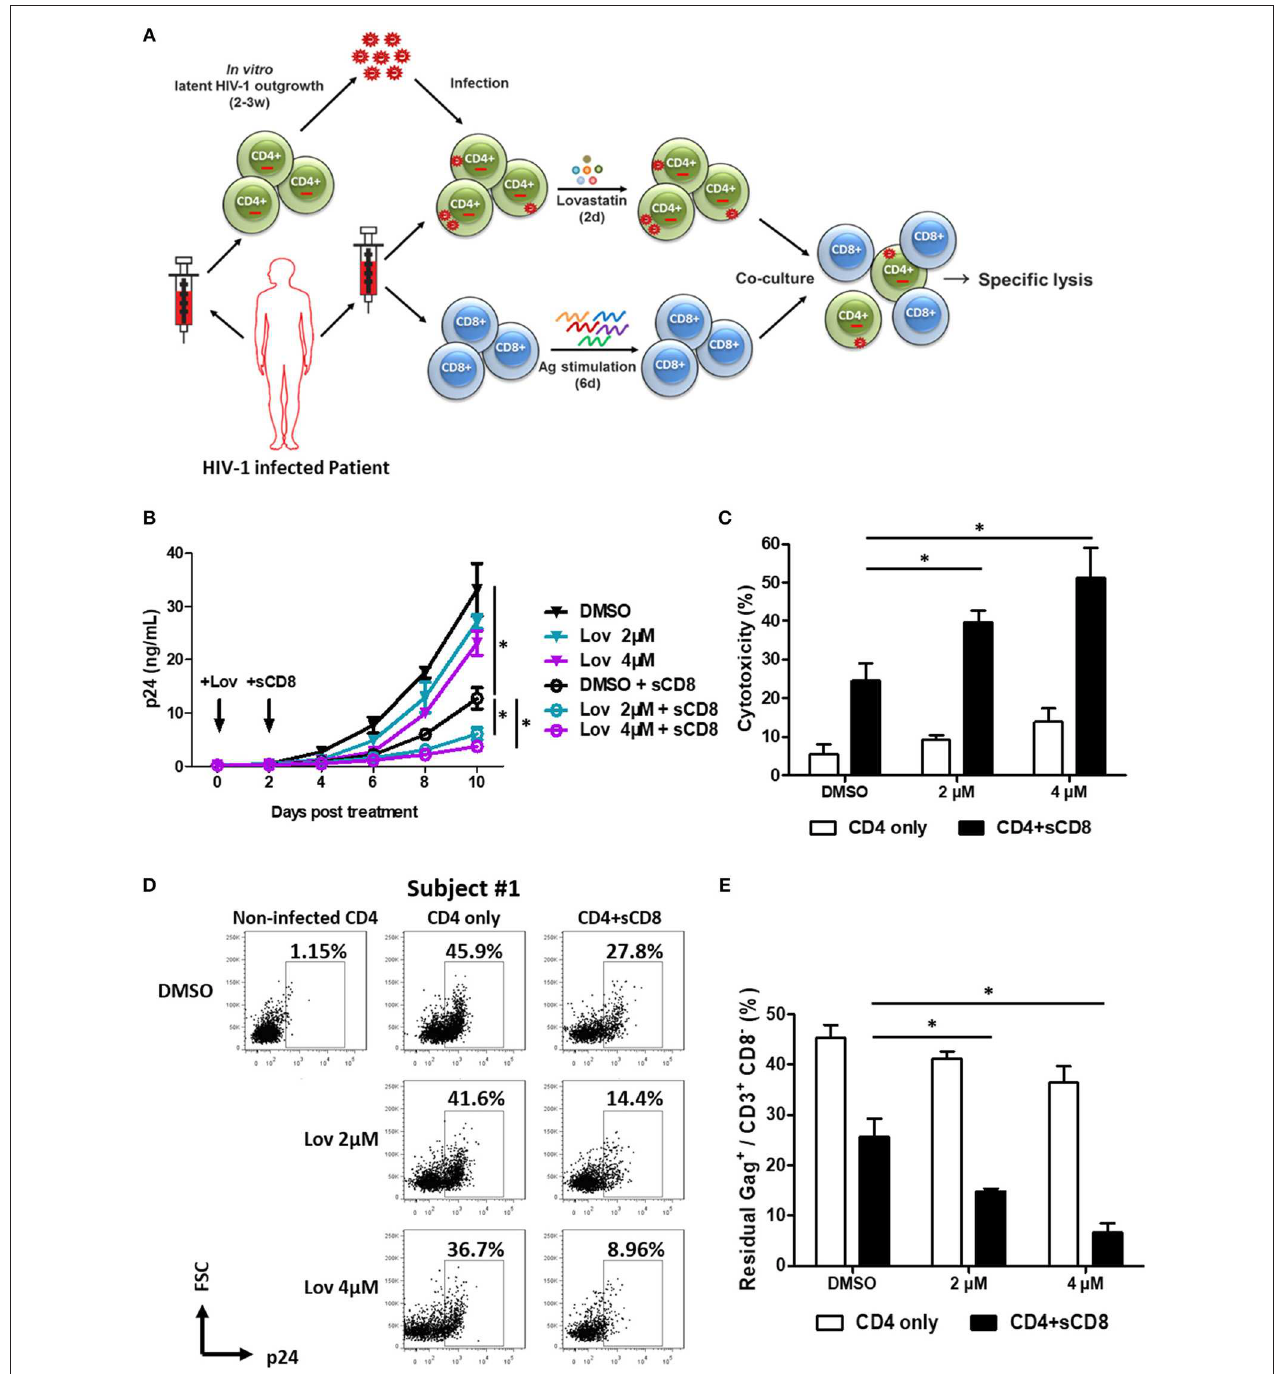
FIGURE 5 | Pre-treatment of lovastatin boosts autologous CTL response against the reactivated latent reservoir from HIV-1 infected individuals. Experimental design. The activated CD4 + T cells from HIV-infected individuals receiving suppressive cART were infected with the viruses recovered from the resting CD4 + T cells of same patients, CD4 + T cells were incubated with lovastatin or vehicle for 48h, then the cells were washed and mixed with autologous Gag peptides-stimulated CD8 + T cells at a 1:1 ratio (A) . Every 2 days the cultures were tested for HIV-1 p24 antigen by ELISA (B) . Eight days after co-culture, specific killing of infected CD4 + T cells by autologous CTLs was determined by LDH assay (C) . The residual Gag + T cells gated on CD3 + CD8 − subpopulation were analyzed by flow cytometry (D) . The ratios of residual Gag + to CD3 + CD8 − subpopulation were summarized from the above flow cytometry analysis (E) . Data show the means ± standard deviations from results of three HIV-1 infected individuals. P -values were calculated using the two tailed paired Student’s t -test with equal variances, n = 3. * p < 0.05.